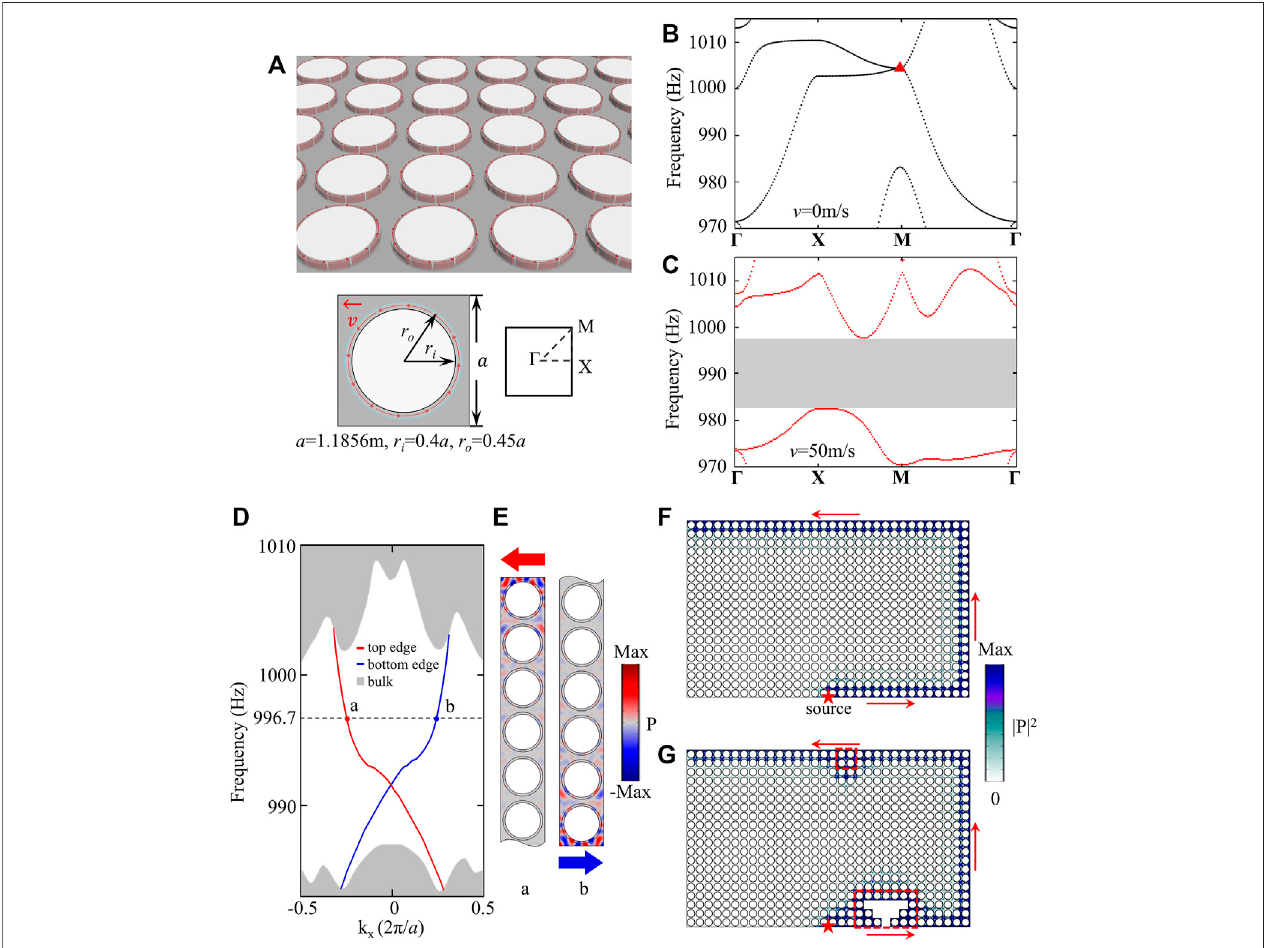
FIGURE 1| An acoustic Chern insulator with C = 1. (A) Schematics of the proposed SC with C 4 v symmetry.The anticlockwise air fl ow is depicted by red arrows in eachunitcell.Theinsetinthelowerrightcorneristhe fi rstBrillionzone(BZ).GeometricparametersfortheSCarealsolisted. (B) BulkbandstructureoftheSCwithoutair fl ow, showing one quadratic degeneracy at the M point (marked by a red triangle). (C) The same as (B) , only with a non-zero anticlockwise air fl ow ( (cid:2) v (cid:2) 50 m/s). The quadratic degeneracy is lifted and a full band gap is opened ranging from 982.5 to 997.75 Hz, as indicated by the grey shading. (D) Projected band structure of a ribbonsupercelloftheSCenclosedinthelowerandupperdirectionsbyrigidboundaries. (E) Pressure fi elddistributionsofthelowerandupperedgemodesat996.7 Hz, corresponding tothosemarked in (D) . Note that forthe sake ofclarity, only partial ofthesupercell ispresented. The red and blue arrows indicate the opposite directions oftheenergy fl owforthesetwoedgemodes. (F) Theintensity fi elddistributionsoftheone-wayedgemodesexcitedat996.7 Hzbyapointsource.Theredstarindicates the position of the source and the red arrows indicate the propagation direction. (G) The same as (F) , only with local perturbations deliberately introduced on the edges (as highlighted by the red dashed